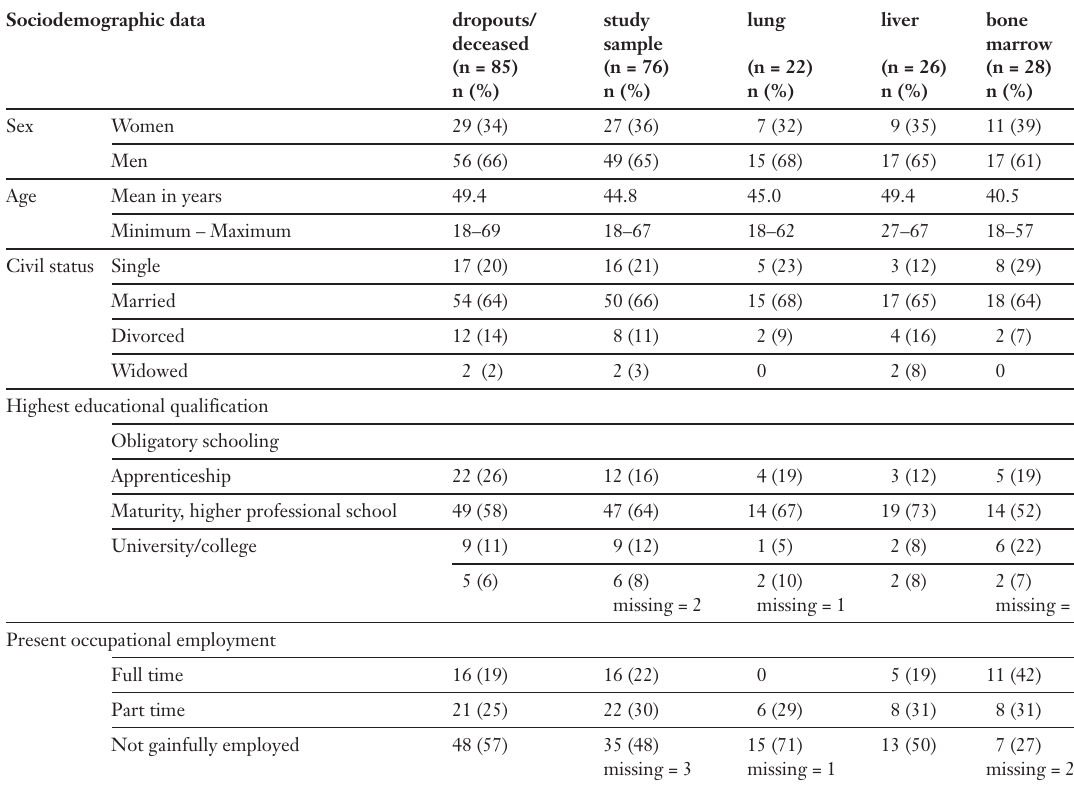
Sociodemographic data at the time of the first inquiry T0 (total sample, N =